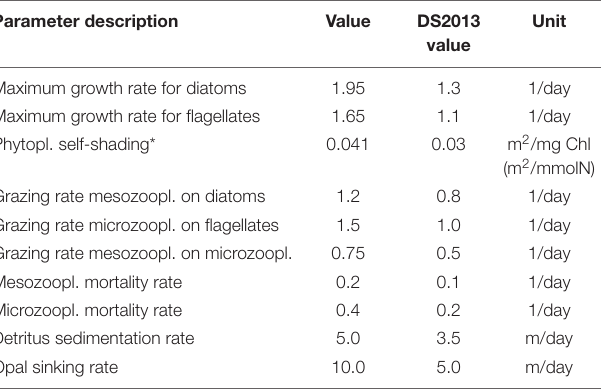
TABLE 2 | The ECOSMO model parameters that have been tuned for HYCOM-ECOSMO compared to those in Daewel and Schrum